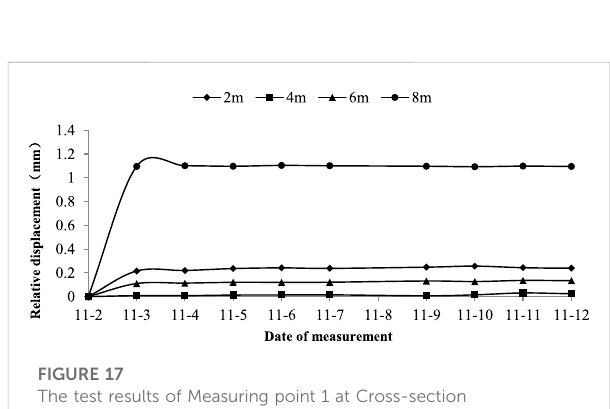
FIGURE 14 The law of left sidewall initial support and secondary lining contact pressure with time at Cross-section ZK330+875.